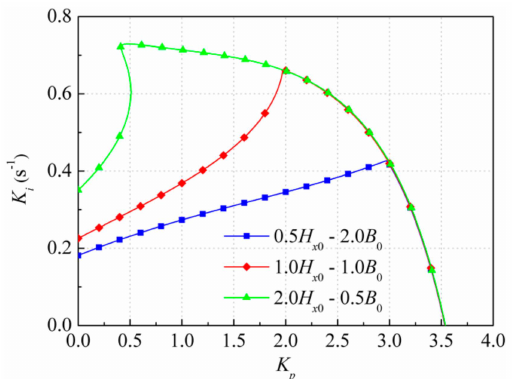
Figure 37. E ff ect of aspect ratio of an SCTT on the stability of an HTGS. Reproduced with permission from [52], Elsevier,